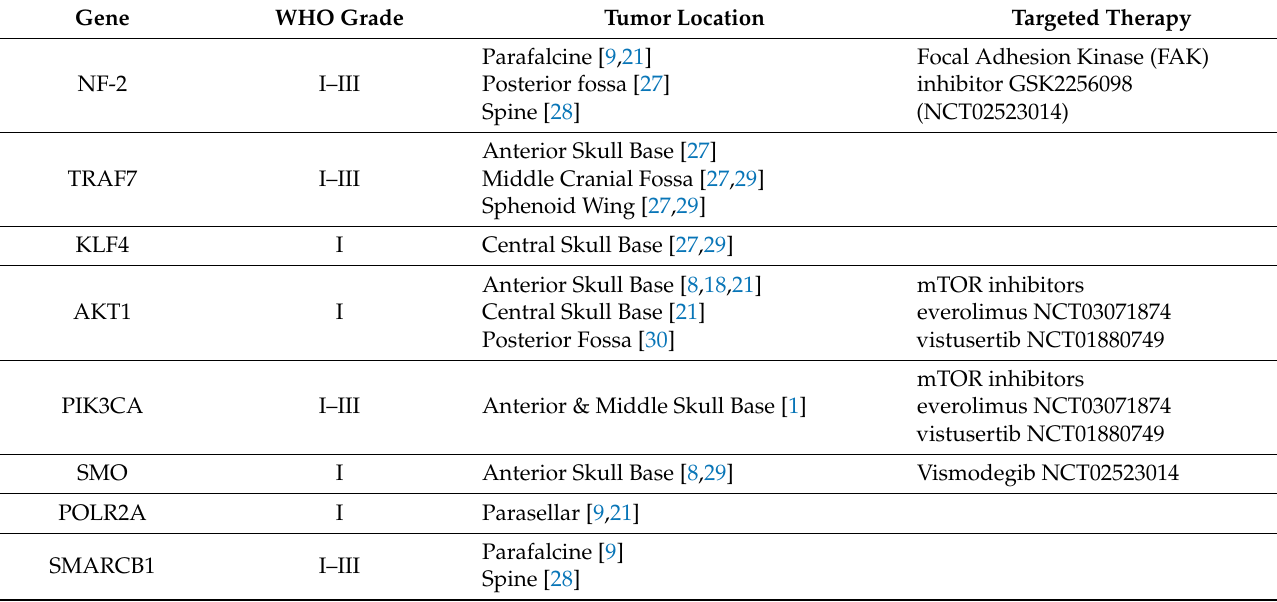
Table 1. Gene alterations of meningiomas with corresponding WHO grade, location, and potential therapies. Abbreviations: NF-2, neurofibromatosis 2; TRAF7, Tumor necrosis factor receptor-associated factor 7; KLF4, Kruppel-like factor 4; ATK1, v-Akt murine thymoma viral oncogene homolog 1; PIK3CA, Phosphatidyl-inositol-4,5-Bisphosphate 3-Kinase Catalytic Subunit Alpha; SMO, Smoothened, frizzled class G protein-coupled receptor; POLR2A, enzyme RNA polymerase II, subunit A; SMARCB1, SWI/SNF-Related, matrix-associated, actin-dependent regulator of chromatin subfamily B member 1.